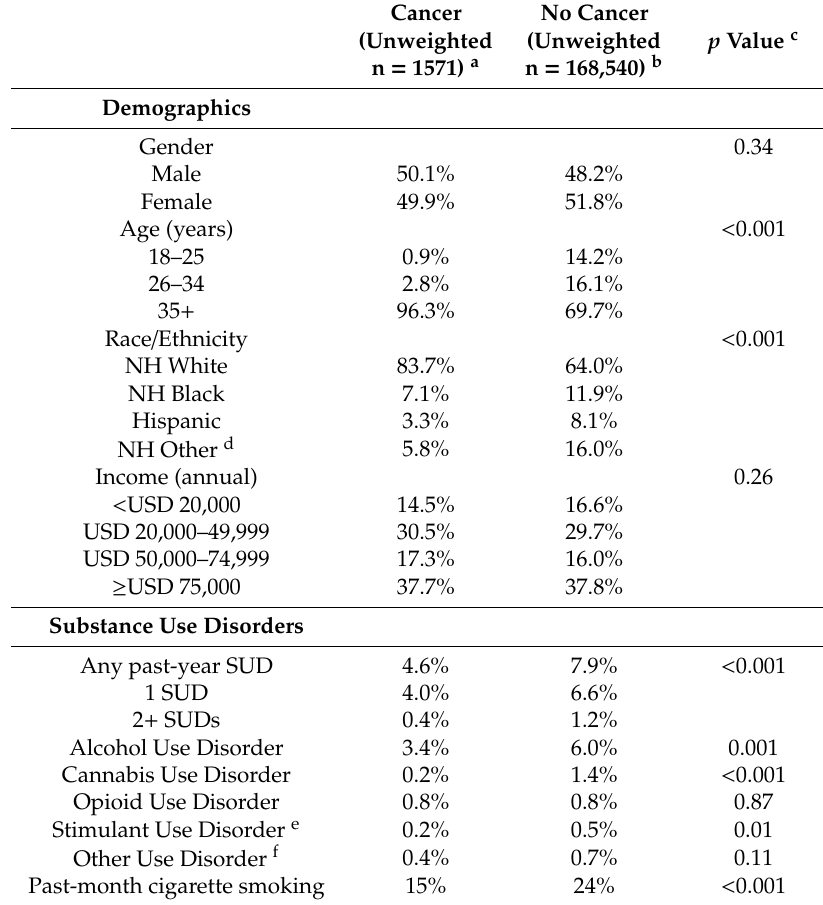
Tabled values represent weighted percentages unadjusted for other demographic characteristics and may not add to 100% due to rounding. NH, non-Hispanic; SUD, substance use disorder. a Weighted n = 3,971,316. b Weighted n = 239,667,703. c p -values compare characteristic values for persons with a past-year cancer diagnosis vs. without a past-year cancer diagnosis. d NH Other category included individuals who identified as NH Native American / Alaskan Native, NH Hawaiian / Pacific Islander, NH Asian, or NH more than one race. e Includes prescription stimulant and cocaine use disorder. f Includes hallucinogen, inhalant,